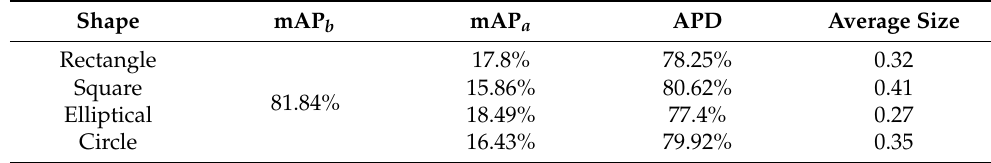
Table 2. Comparison of the different-shaped patches.